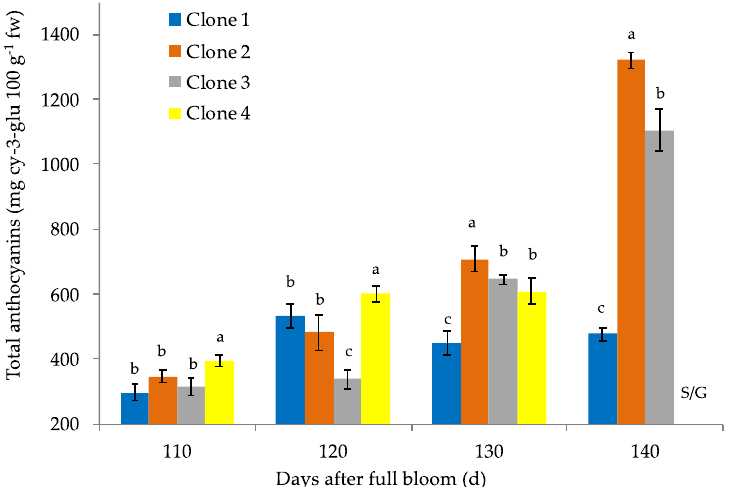
Figure 5. Concentration of total anthocyanins in the fruit for four calafate clones according to the different harvest dates. Lowercase letters indicate significant differences between the different clones for the same harvest date, according to the Fischer test ( p < 0.05). S/G = no harvest.